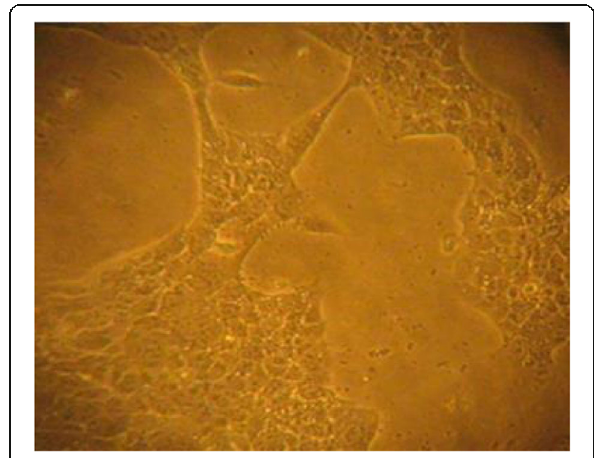
Fig. 5 Sensitivity of 4TI cancer cells to green tea at IC 50 of 13.12 μ g/ml showing disruption of